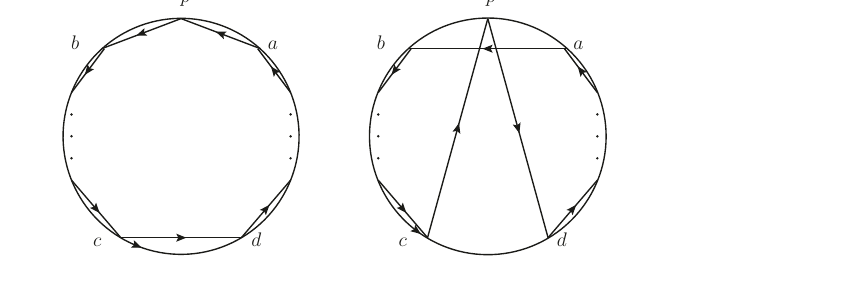
Figure 5 . Disk diagrams for A S ( ··· ,a,p,b, ···|··· ,a,p,b, ··· ) and A S ( ··· ,a,p,b, ···|··· ,c,p,d, ··· )